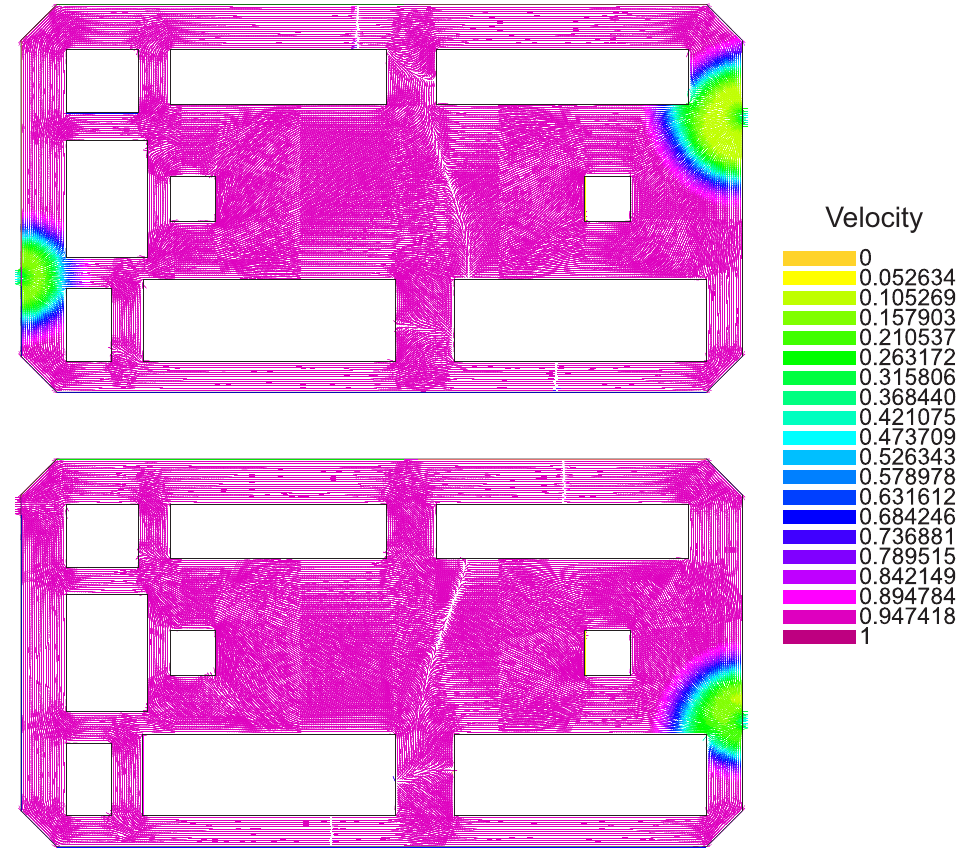
Figure 7. Case 2: Normalized pedestrian velocities u / u max at final time t = 350 for the initial ( top ) and the optimal locations ( bottom ) of exit doors (shown by outward arrows on the